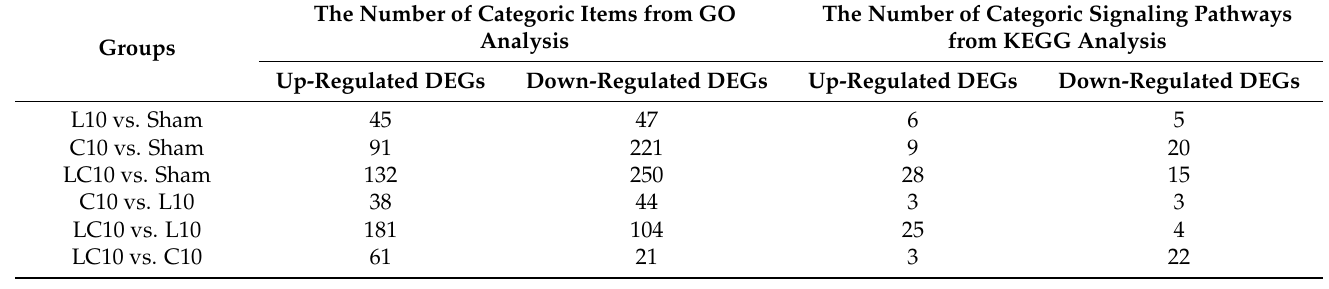
(Figure 5A,C, Table 4, Supplementary Figure S2, Supplementary Files S1 and S2). Selected DEPs from peripheral blood and the spleen were verified by mass spectrum (Figure 5B,D). Table 3. The gene set enrichment analysis of DEGs after compound microwave exposure in the spleen.